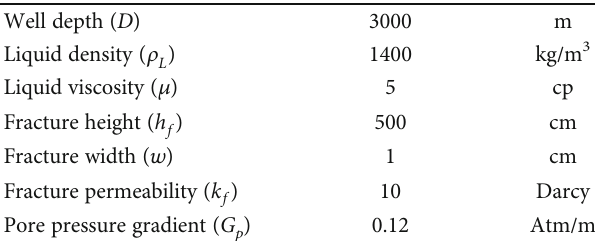
Table 1: Fluid and fracture properties for model